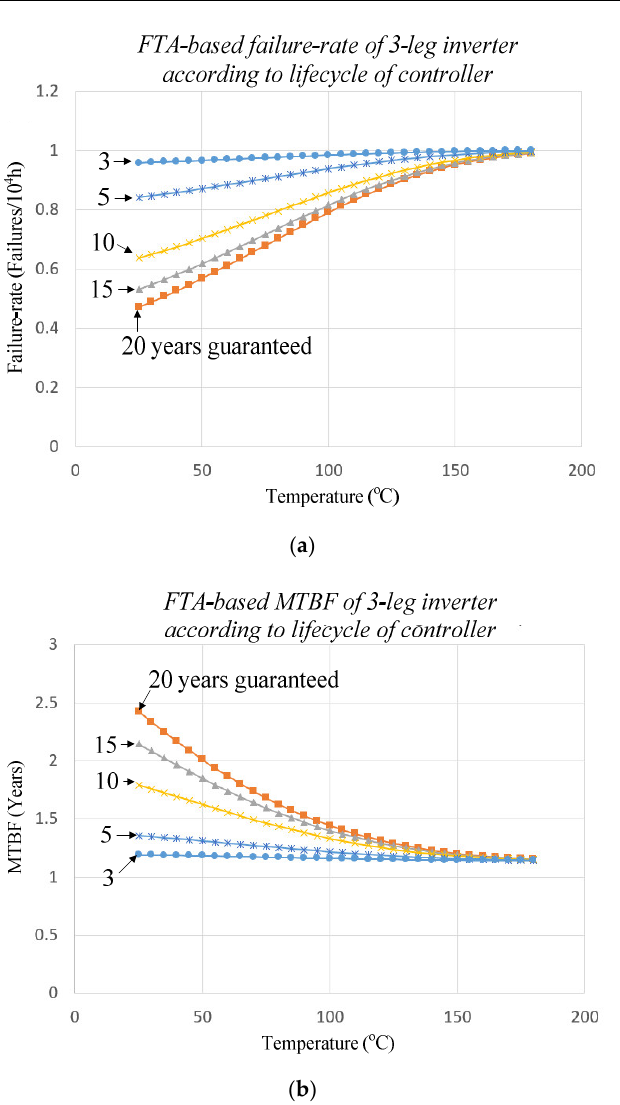
Figure 14. Failure rate and MTBF of 3-leg inverter according to the controller lifecycle: ( a ) Failure rate; ( b ) mean time between failures, year.